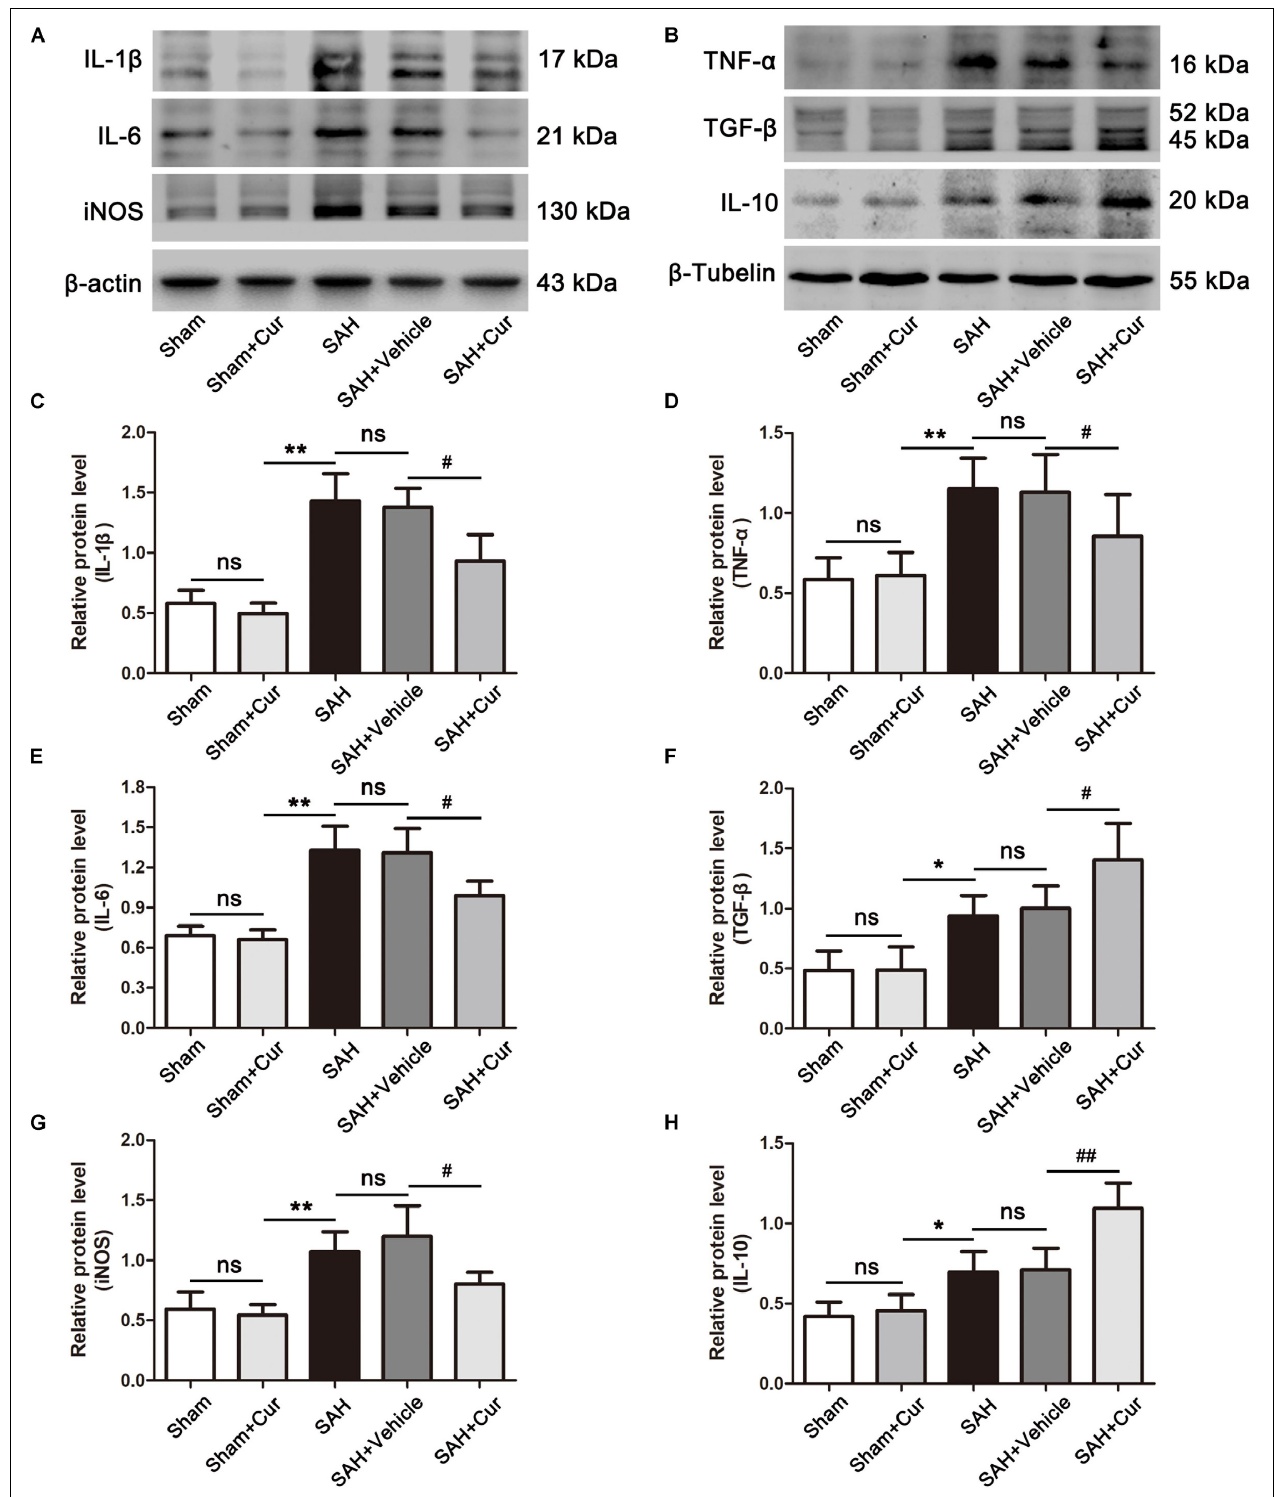
FIGURE 6 | Effects of curcumin treatment on neuro-inflammatory cytokines release at 24 h after SAH. (A,B) Western blotting showed curcumin treatment obviously reduced the elevated pro-inflammation cytokines IL-1 β (C) , IL-6 (E) , TNF- α (D) , and iNOS (G) as compared with the SAH + vehicle group, meanwhile increased the expressions of anti-inflammation mediators TGF- β (F) and IL-10 (H) at 24 h after SAH. The quantitative data are the mean ± SD ( n = 5, each; ∗ p < 0.05, ∗∗ p < 0.01 vs. Sham + Cur group; # p < 0.05, ## p < 0.01 vs. SAH + Vehicle group; ns p > 0.05).